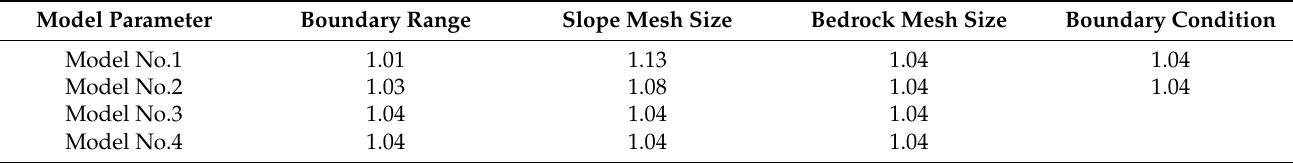
Table 8. Slope stability coefficient with different model